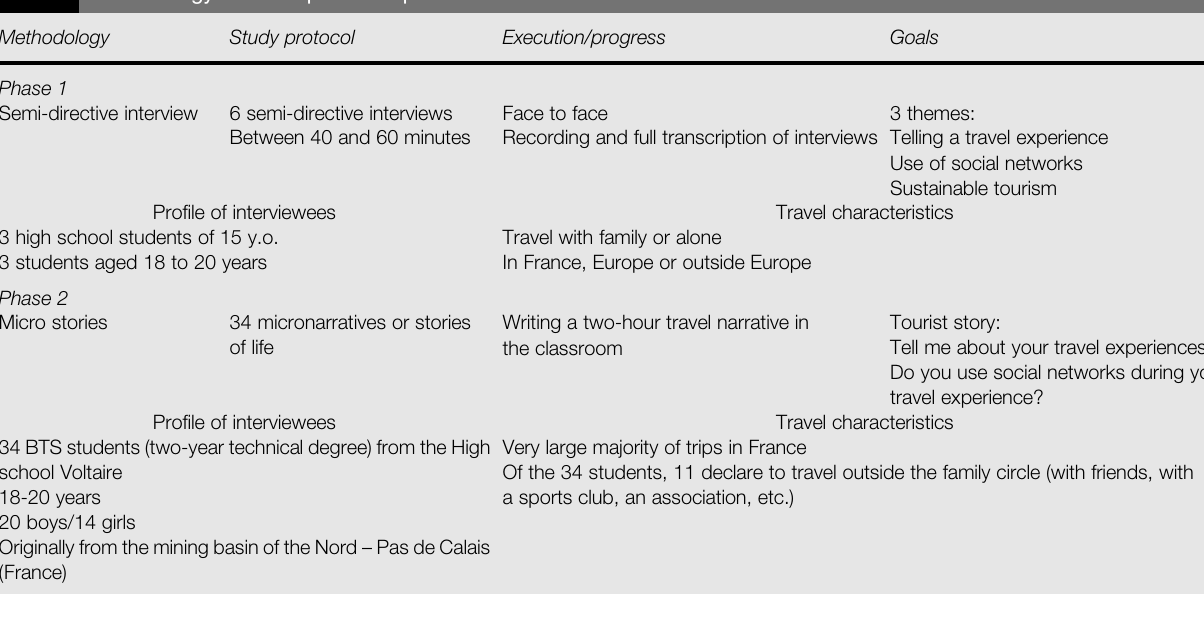
Table I. Methodology and sample description